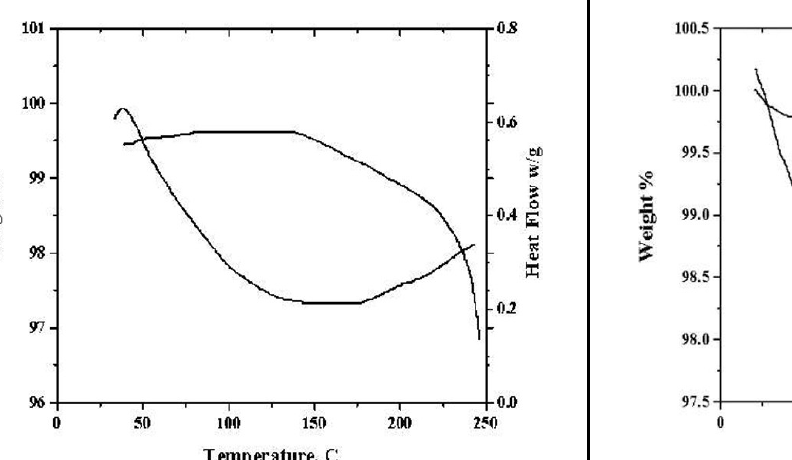
FIG. 13. DSC AND TGA CURVE FOR 7 DAYS AGED SAMPLE (MULTI STRESSED)